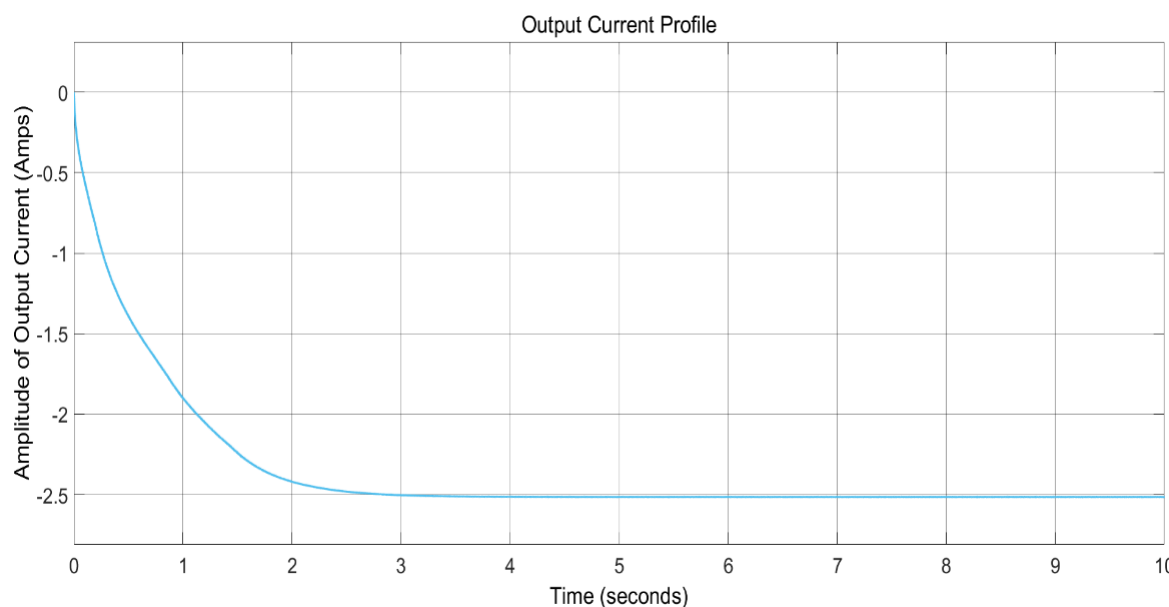
Figure 10. Output current profile.